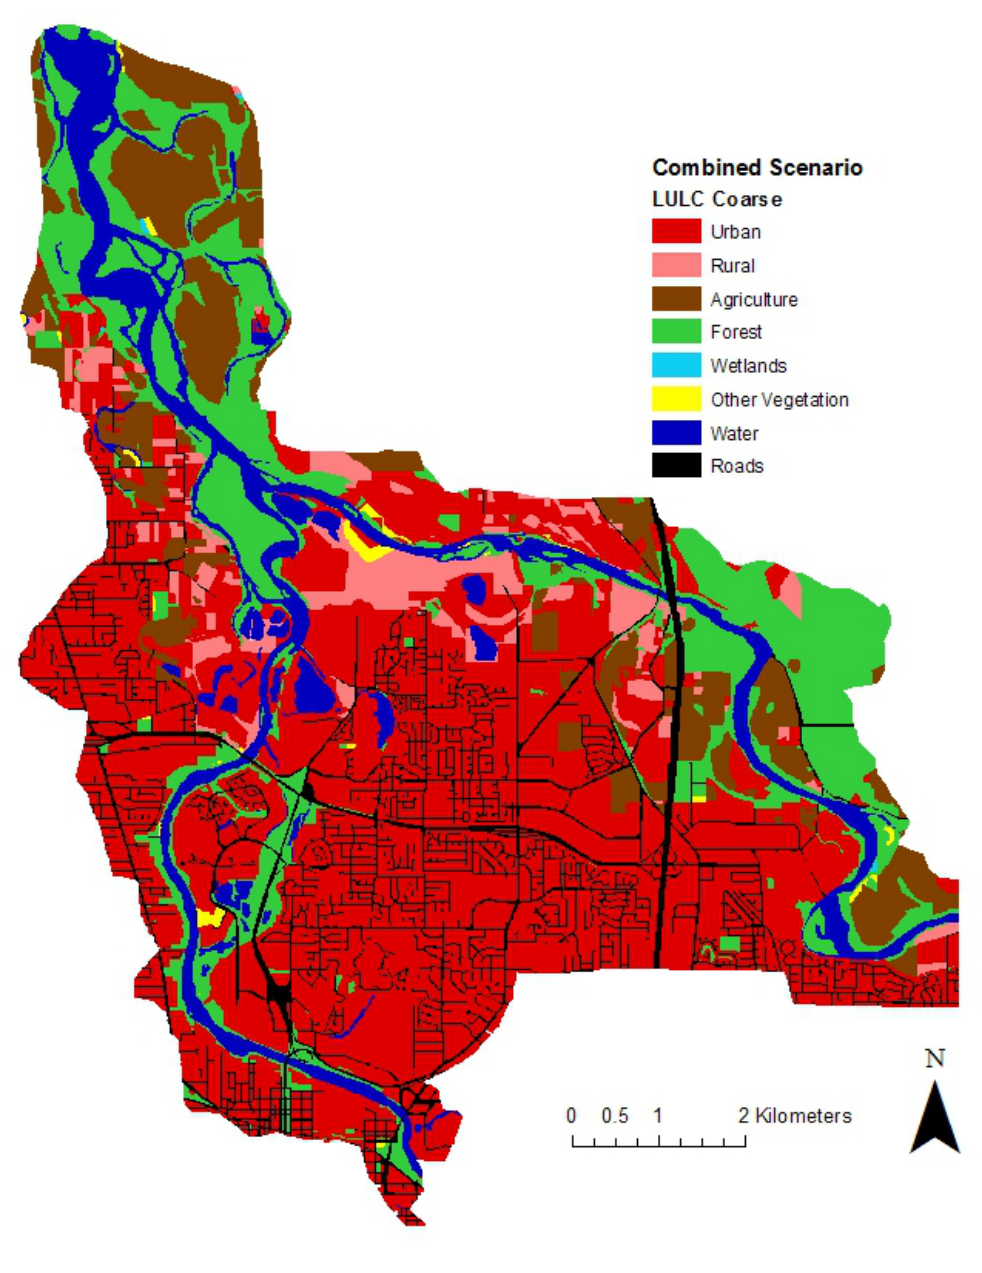
Fig. 12 . Study area after a typical 50-yr run of the combined policies in the fish conservation and unconstrained development scenarios in which the urban growth boundary and the agricultural and forest reserve policies are included. LULC stands for land use and land